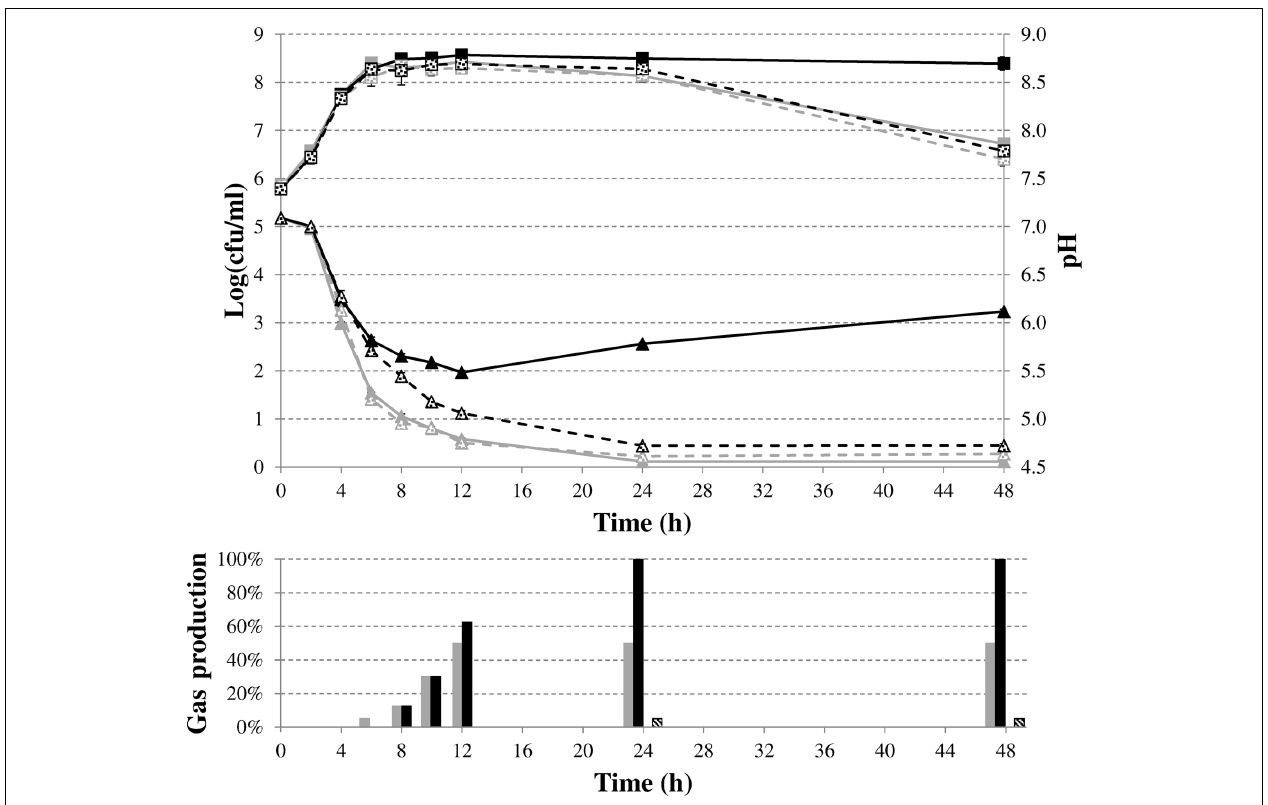
FIGURE 3 | Cell numbers (squares) and medium pH (triangles) during fermentative growth of E. coli MG1655 wild-type (solid lines) or (cid:2) hycE (dashed lines) containing pTrc99A (gray) or pTrc99A-P trc - budAB (black)